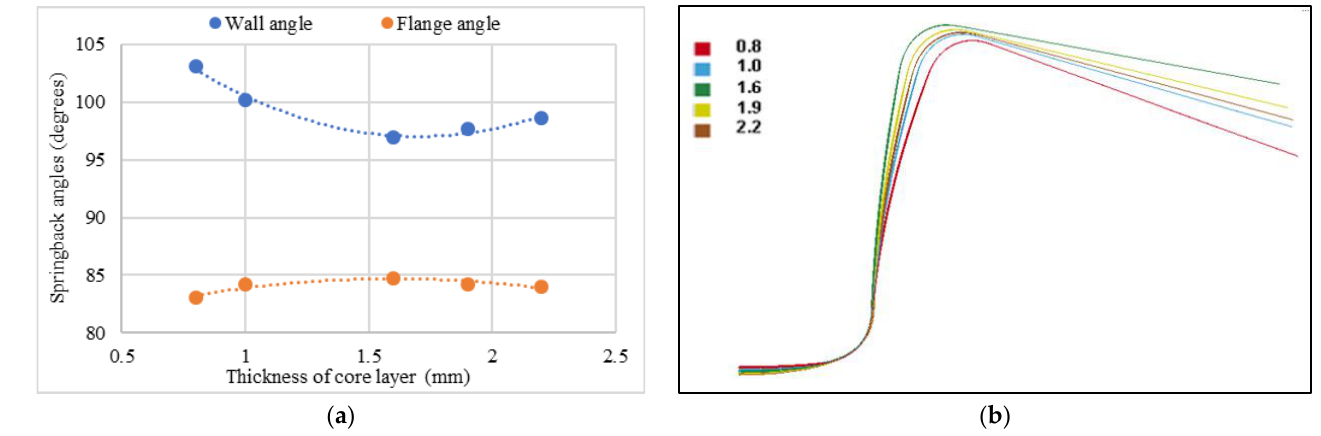
Figure 11. Effect of increasing core thickness at a constant skin thickness of 0.24 mm on ( a ) springback angles ( b ) U-channel profiles.